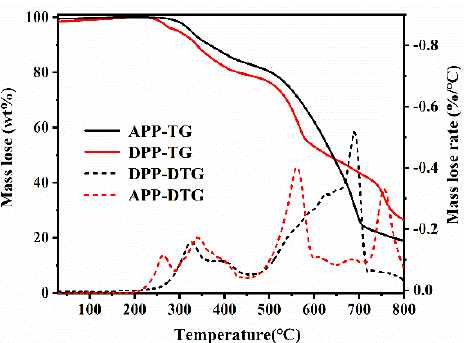
Figure 5. The mass loss and mass loss rate curves of DDP and APP at a heating rate of 10 °C min − 1 under a nitrogen gas flow rate of 50 mL min − 1 .